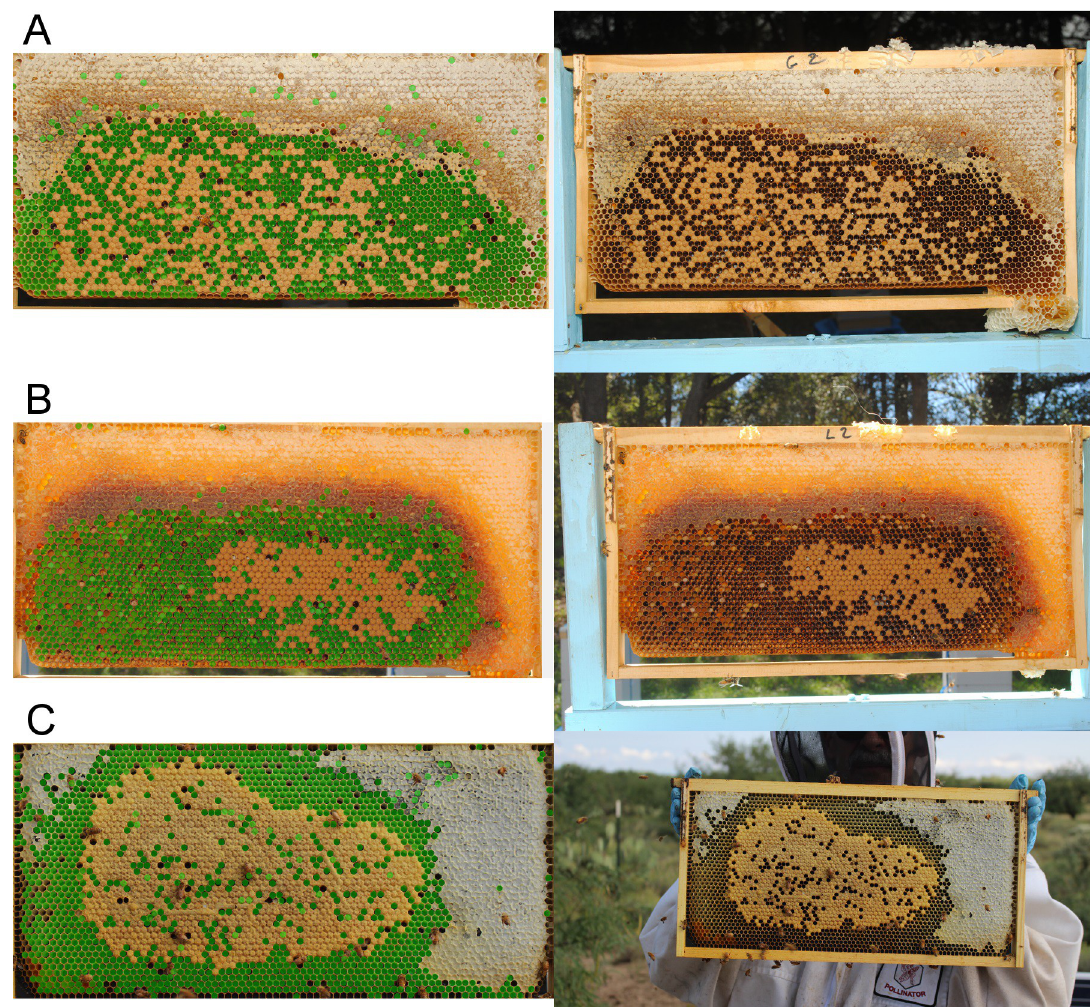
Fig 1. Examples of three frame photos taken in different lightening conditions and their corresponding empty cell detection estimations from CombCount. (A) Photo taken in Sydney, with the 10Mpx Nikon D3000 without flash, (B) Photo taken in the same conditions but with flash, and (C) Photo taken in Arizona, with the 16.3 Mpx Pentax K-01 without flash.